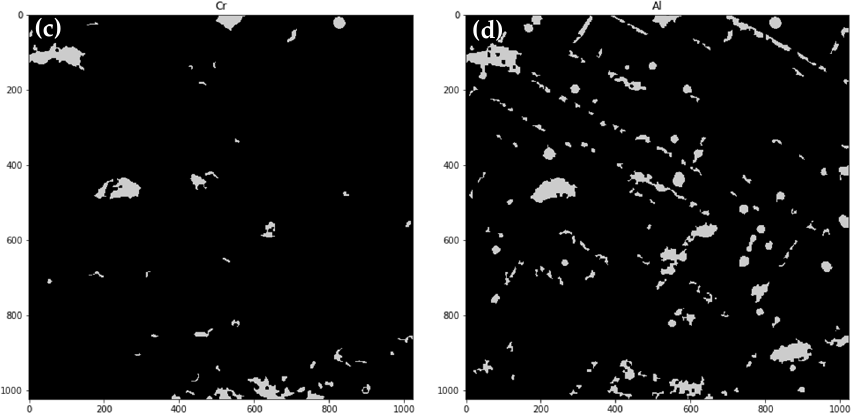
Figure 12. Regions identified as “uncommon” with components share in upper quartile, respectively, O ( a ), Ni ( b ), Cr ( c ) and Al ( d ).